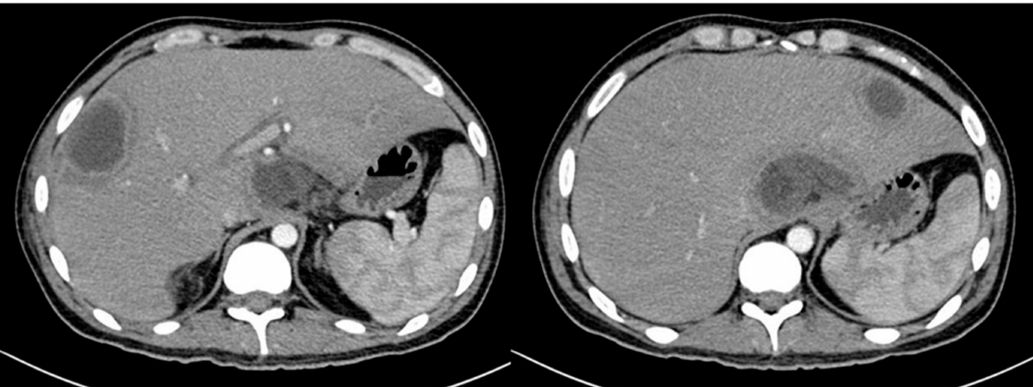
Figure 1. Abdominal CT scan with intravenous contrast, which shows: Diffuse and poorly defined hypodense lesions, one located in the liver segment II measuring 3.4 cm, another located in the caudate lobe measuring 7 cm, and another located in the hepatic segment VII with extension to segment VI measuring 7 cm; consistent with liver